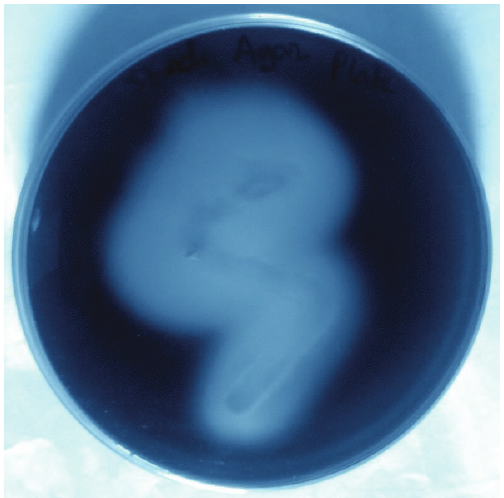
Figure 1: Starch hydrolysis performed on a 2% starch agar plate using B. amyloliquefaciens (MTCC 1270).